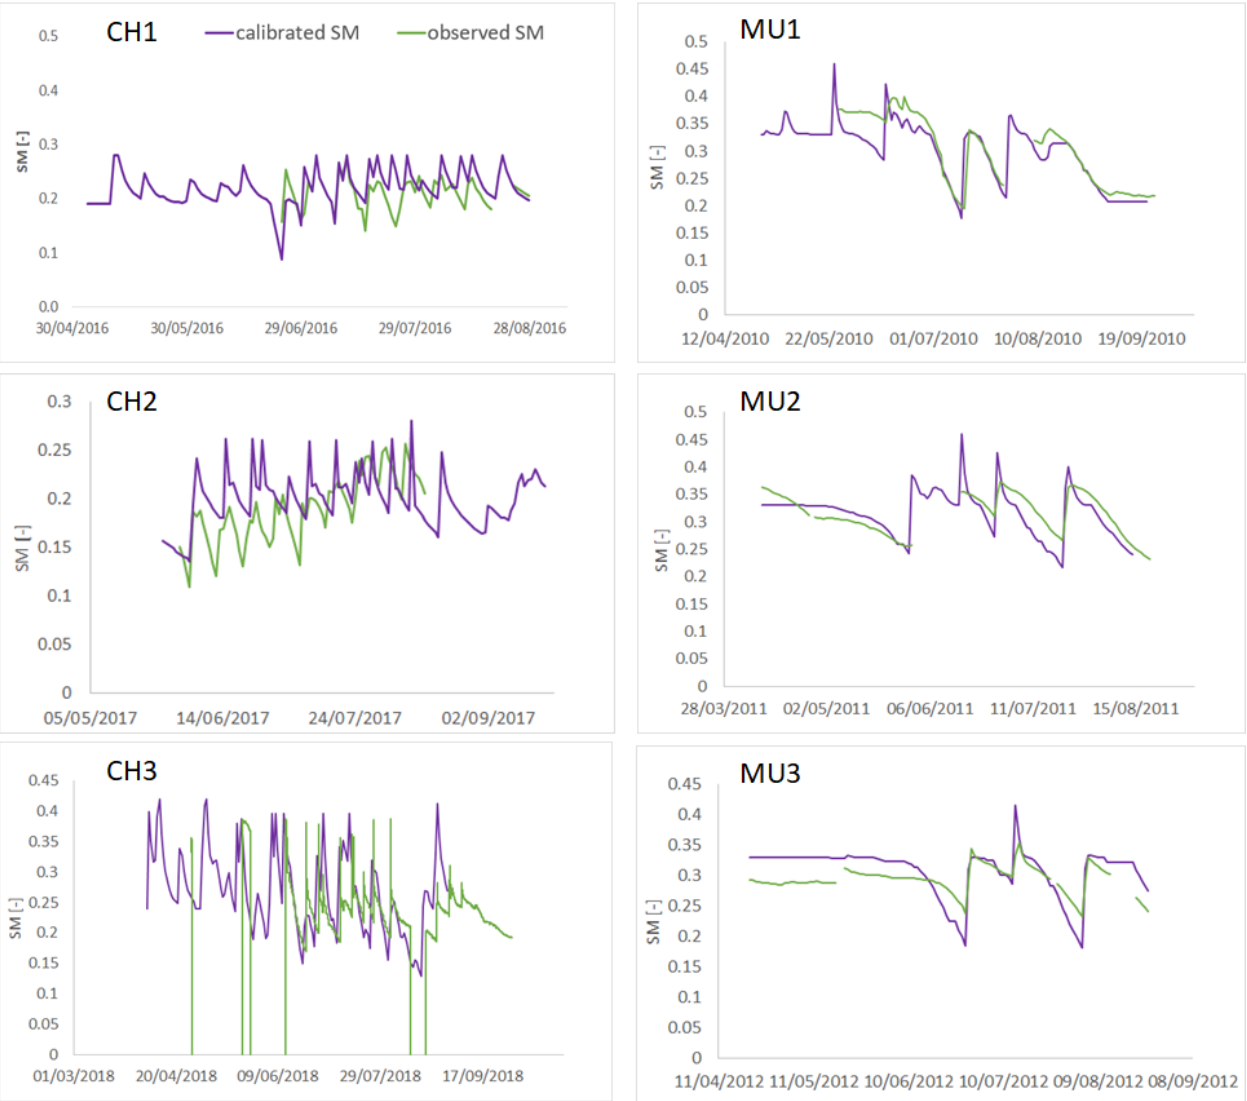
Figure 4. Modeled soil moisture for the Chiese and Muzza stations against ground measurements. The error of yield is less than 2 ton/ha, while an MAE and an RMSE of 1.3 and 0.4%, respectively, are obtained for canopy cover. The ability of the model to reproduce the temporal dynamic of crop grow coverage is shown in Figure 5 against the satellite data. During the validation phase, a high accuracy is also obtained for 2017 soil moisture estimates, with an MAE of 0.021 and an RMSE of 0.4 (Figure 4), while the production is slightly less than the observed one, with an error of 1 ton/ha. An error of 1.5 ton/ha is obtained for 2018. The canopy cover dynamic is well reproduced (Figure 5) both in 2017 and 2018, with an MAE of 3.6 and 7%, respectively. Evapotranspiration is also well simulated, with an MAE of 0.4 mm/day during the 2017 crop season and 0.3 mm/day during